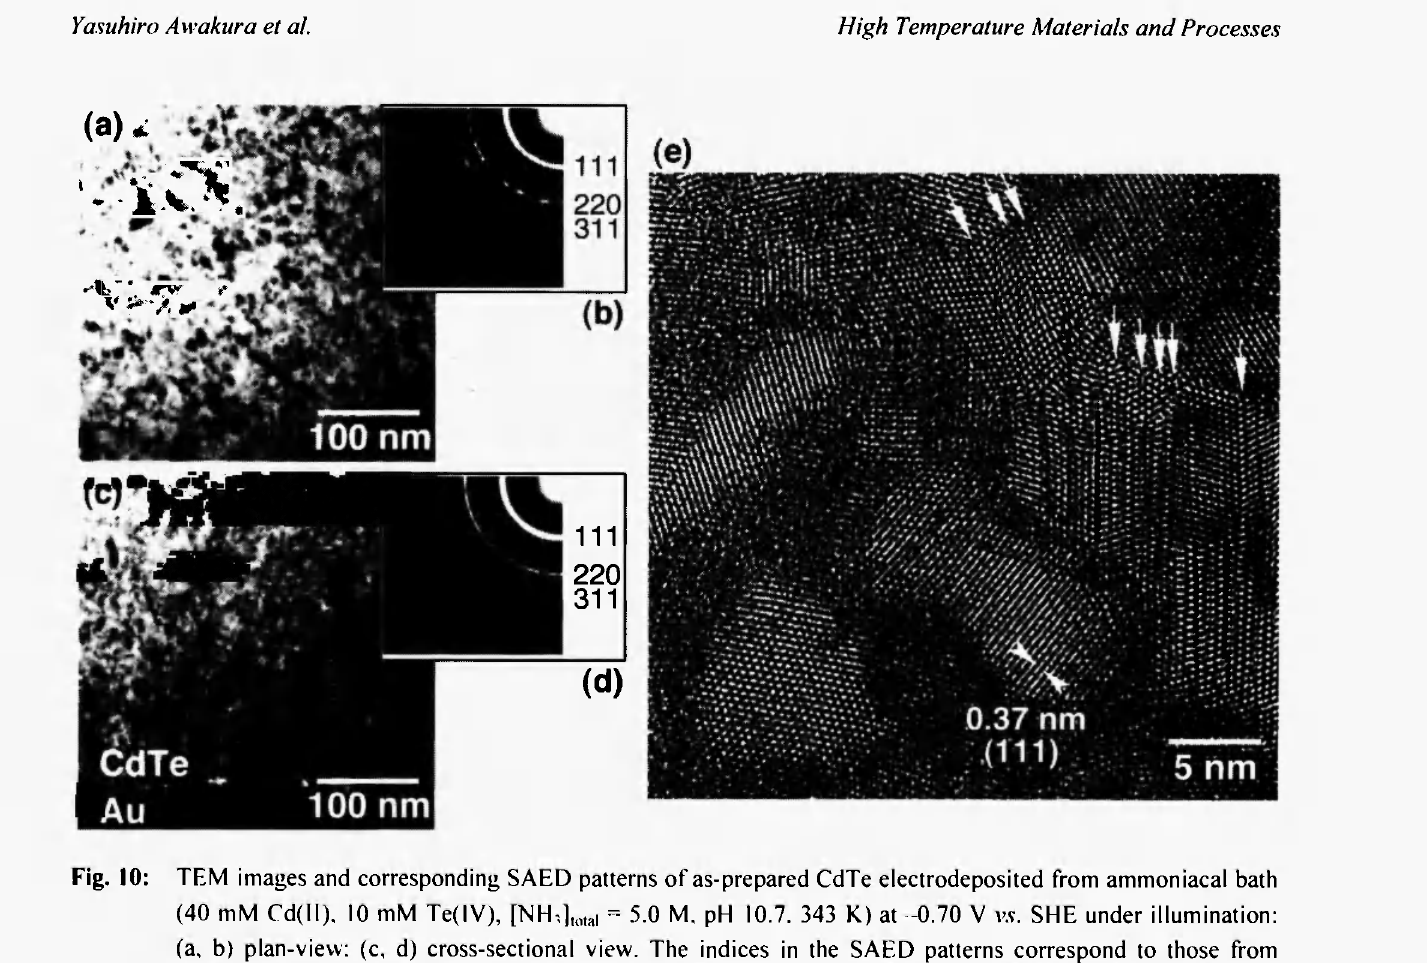
Fig. 10: TEM images and corresponding SAED patterns of as-prepared CdTe electrodeposited from ammoniacal bath (40 mM Cd(ll), 10 mM Te(IV), [NH,],„.ai = 5.0 M, pH 10.7. 343 K) at -0.70 V v.v. SHE under illumination: (a, b) plan-view: (c, d) cross-sectional view. The indices in the SAED patterns correspond to those from CdTc. High-resolution TEM image (e) for the CdTe is also given; white arrows indicate planar defects on {111}